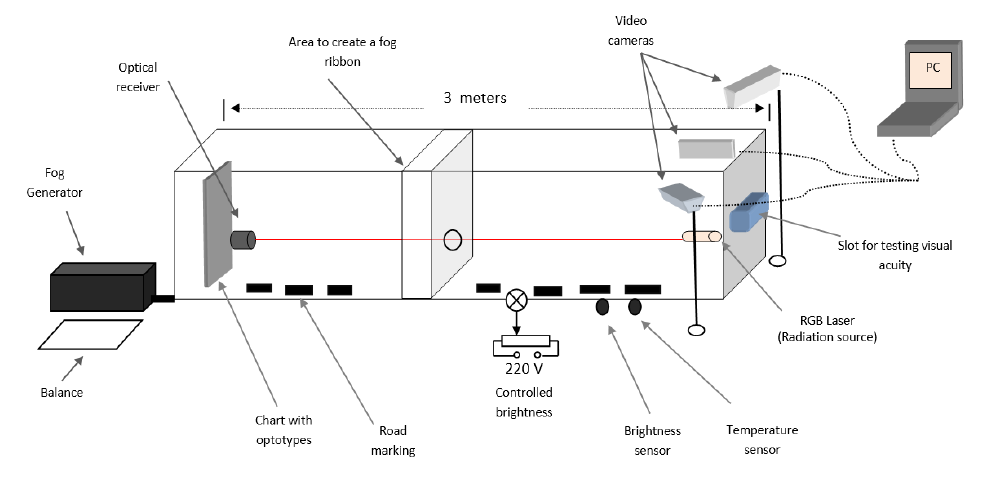
Figure 2. Experimental